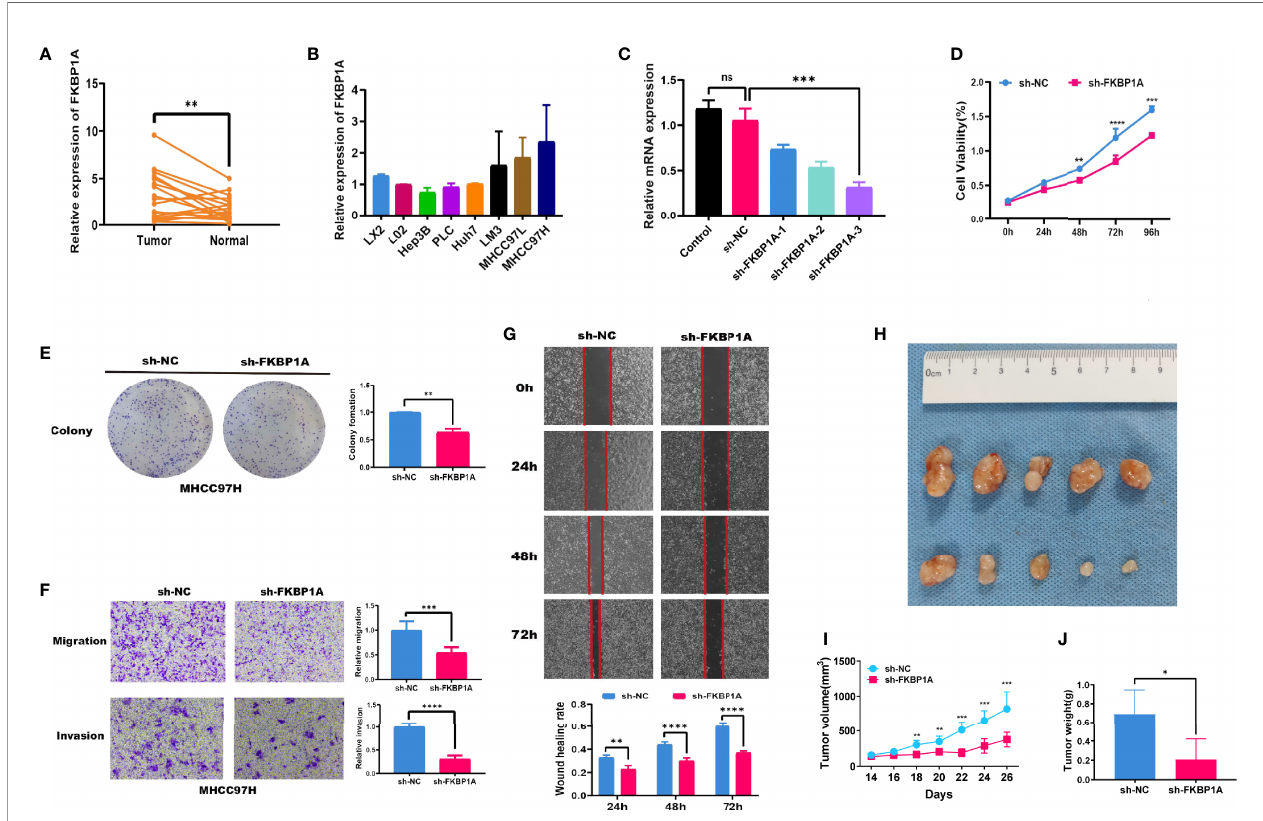
FIGURE 9 | FKBP1A expression in HCC tissues and the effects of FKBP1A on HCC cell biological behaviors in vitro and in vivo . (A) qRT-PCR analysis of FKBP1A expression in HCC tissues from patients compared with adjacent non-cancerous tissues. (B) Levels of FKBP1A in HCC cell lines, a human hepatic stellate cell line, and a normal liver cell line. (C) qRT-PCR was performed to detect the ef fi ciency of sh-FKBP1A-1, 2, and 3 transfection. (D) Growth curves for transfected MHCC97H cells were determined using the CCK-8 assay. (E) A colony formation assay was performed to assess the colony forming ability after transfection. (F) MHCC97H cells expressing a control shRNA or FKBP1A shRNA were subjected to Transwell migration and invasion assays. (G) Wound healing assays with MHCC97H cells expressing the control shRNA or FKBP1A shRNA. (H) sh-FKBP1A suppresses tumor growth in vivo . (I) The length and width of the tumors were measured using Vernier calipers. The tumor volume was calculated, and the tumor growth curves were plotted. (J) After 26 days, the nude mice were euthanized, and the tumor tissues were weighed. Ns, not signi fi cant, *p < 0.05, **p < 0.01, ***p < 0.001 and ****p < 0.0001. Data are presented as the means ± SD (n ≥